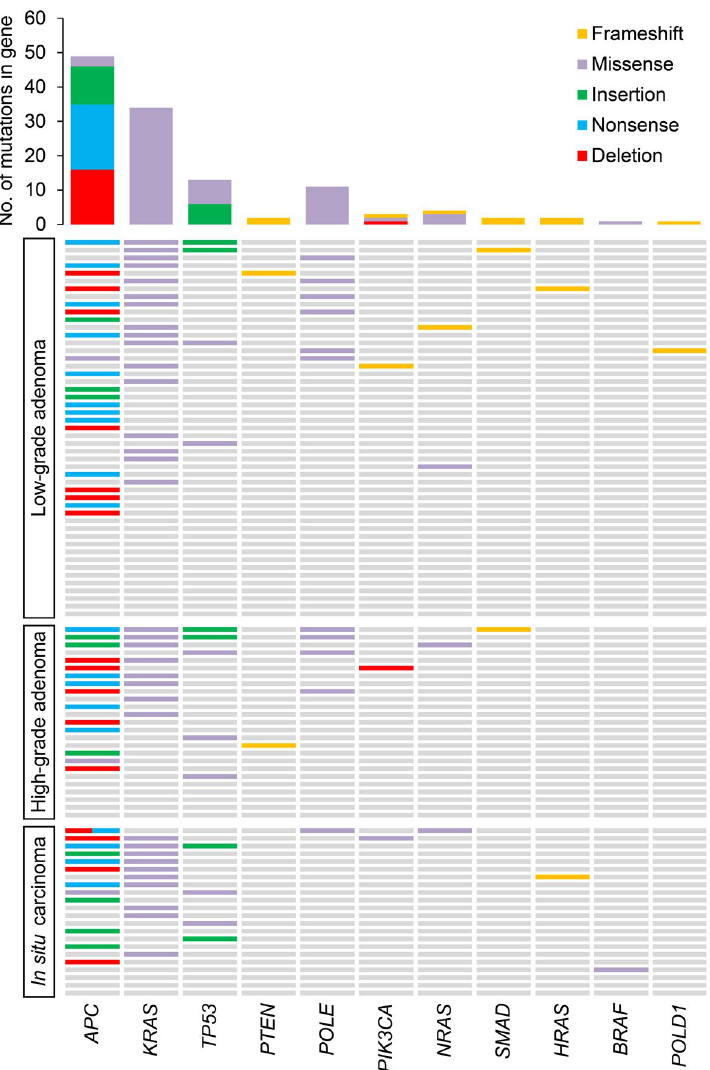
Figure 2. The distribution of genetic alterations detected in low-grade, high-grade adenomas, and in situ carcinomas. Each row represents a patient, and each column represents a gene. Different mutation types are indicated by different colors. The bar chart on the top shows the total number of the given gene’s mutations observed in the